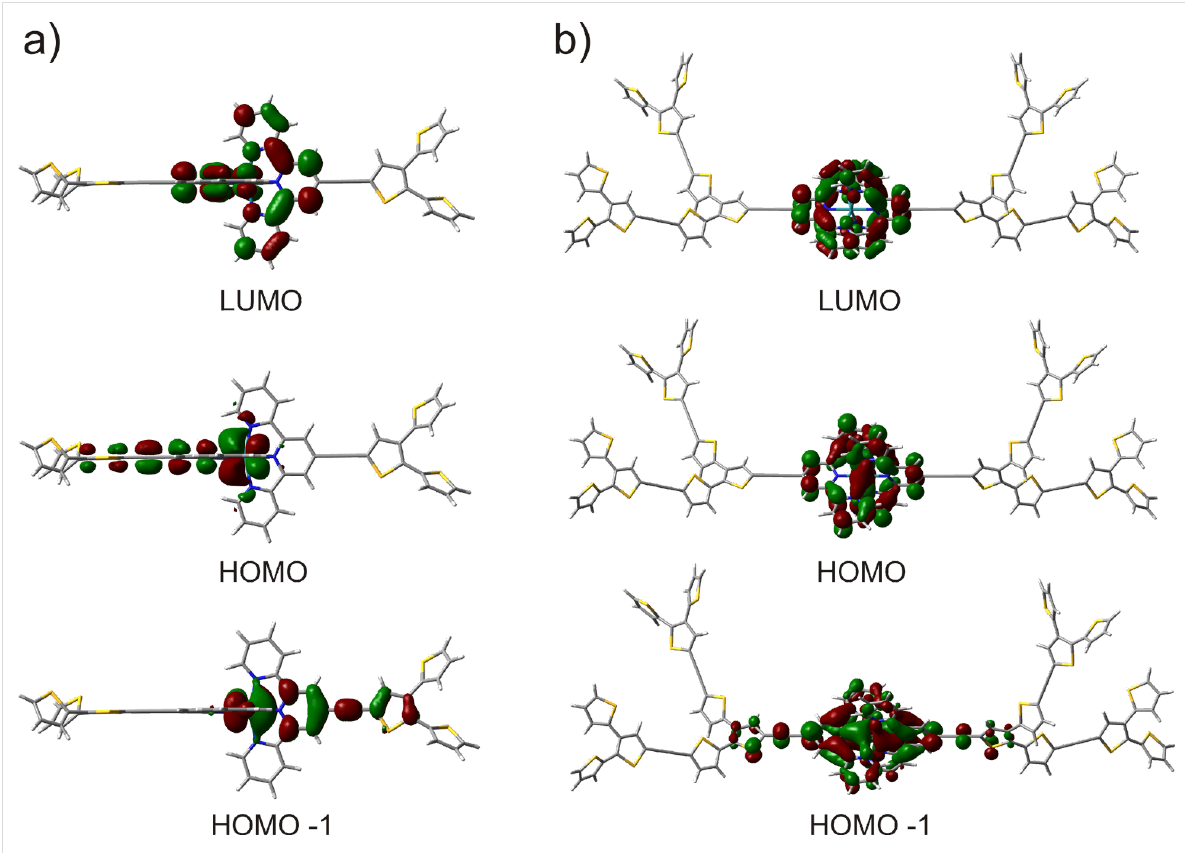
Figure 2: Electronic distribution of the frontier orbitals (HOMO, HOMO-1 and LUMO) for complexes 1 (a) and 2 (b).